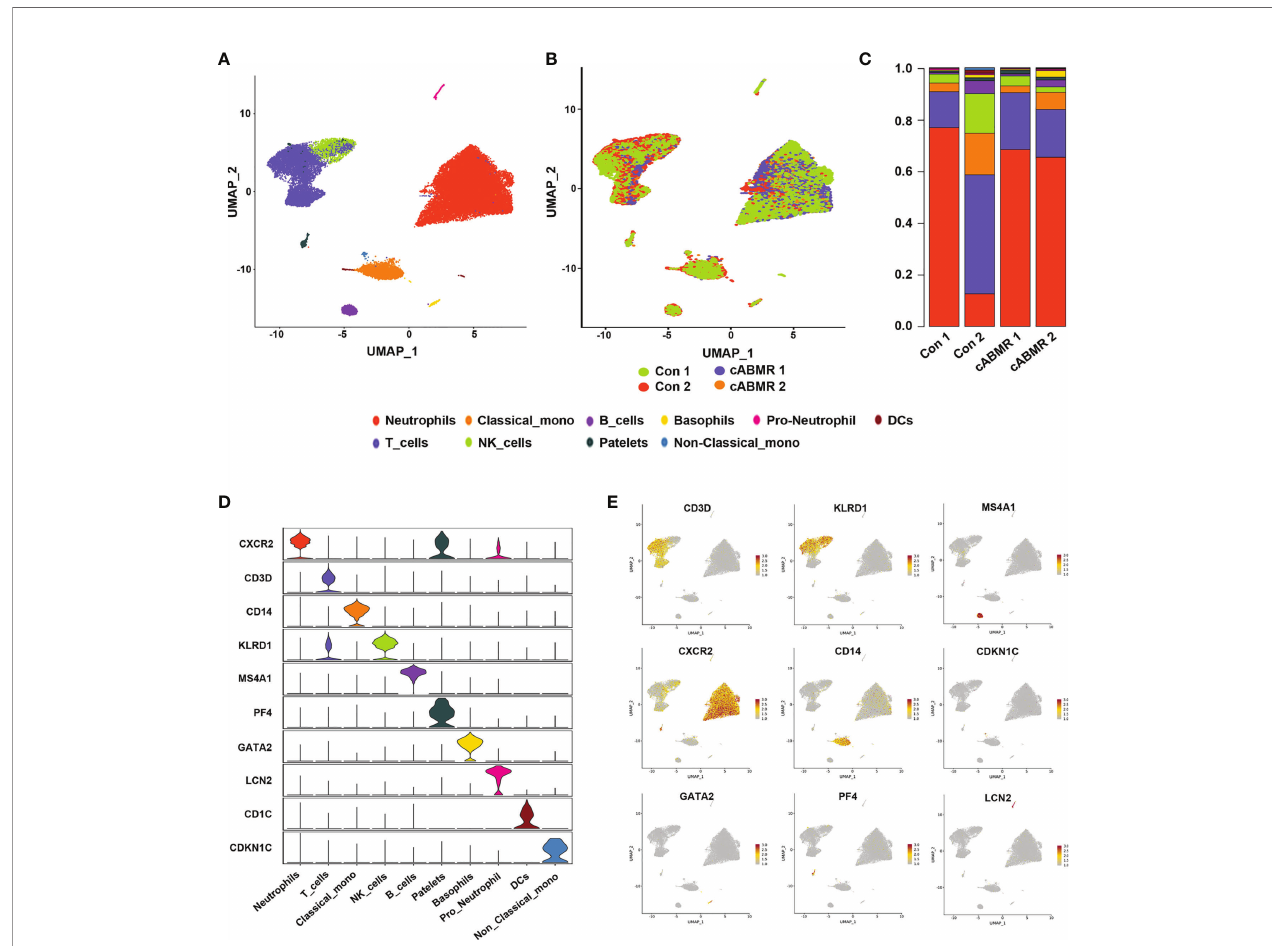
FIGURE 2 | Differences in cell cluster composition between patients in Control group and cABMR group. (A, B) UMAP dimensional-reduction projection analysis of samples from the control group (n=2) and the cABMR group (n=2), (A) is stained by cell type source, and (B) is stained by group source, each dot corresponds to a single cell; (C) The mean proportion of each cell subsect from the Control group (n=2) and the cABMR group (n=2); (D) Violin plot of selected marker genes that identi fi ed the clusters generated by UMAP plotting. It was colored by different cell subtypes. (E) Canonical cell markers were used to label clusters by cell identity as represented in the UMAP plot. Data are colored according to expression levels and the legend is labeled in log